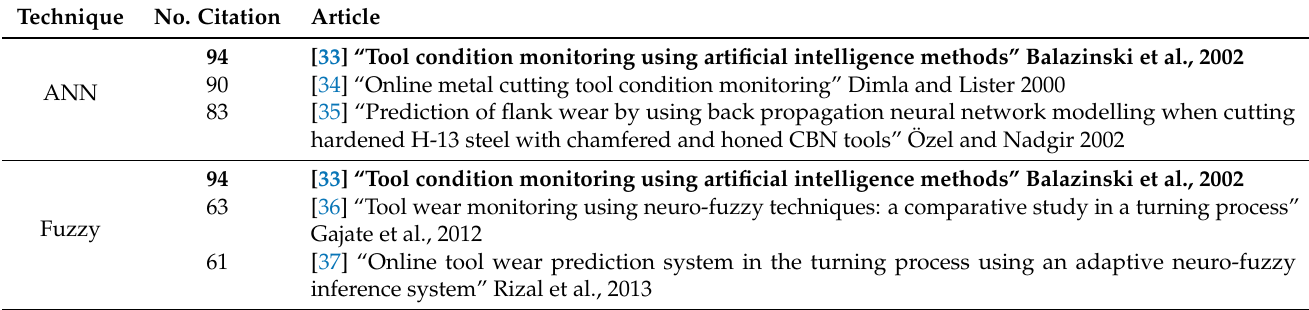
Table 2. Top 3 most cited articles by AI techniques, three globally most cited articles in boldface type.